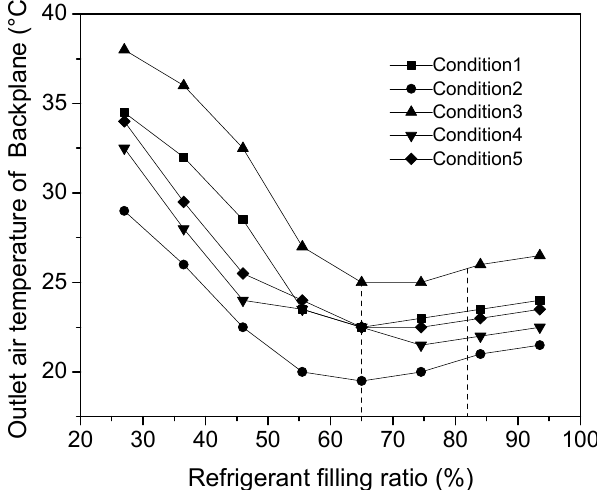
Figure 5. Relationship between liquid filling rate and backplane outlet temperature under different temperature conditions.